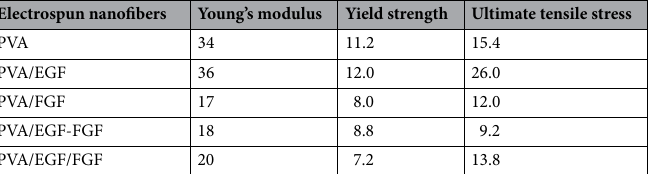
Electrospun nanofibers